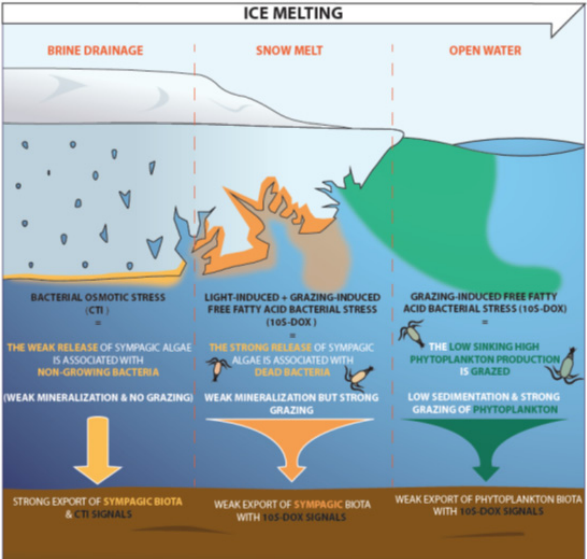
Figure 4. Conceptual scheme summarizing bacterial stress and its consequences on sympagic algae export in the Beaufort Sea and northern and western Baffin Bay during the sea ice melting stages: brine drainage, snowmelt, and open water.